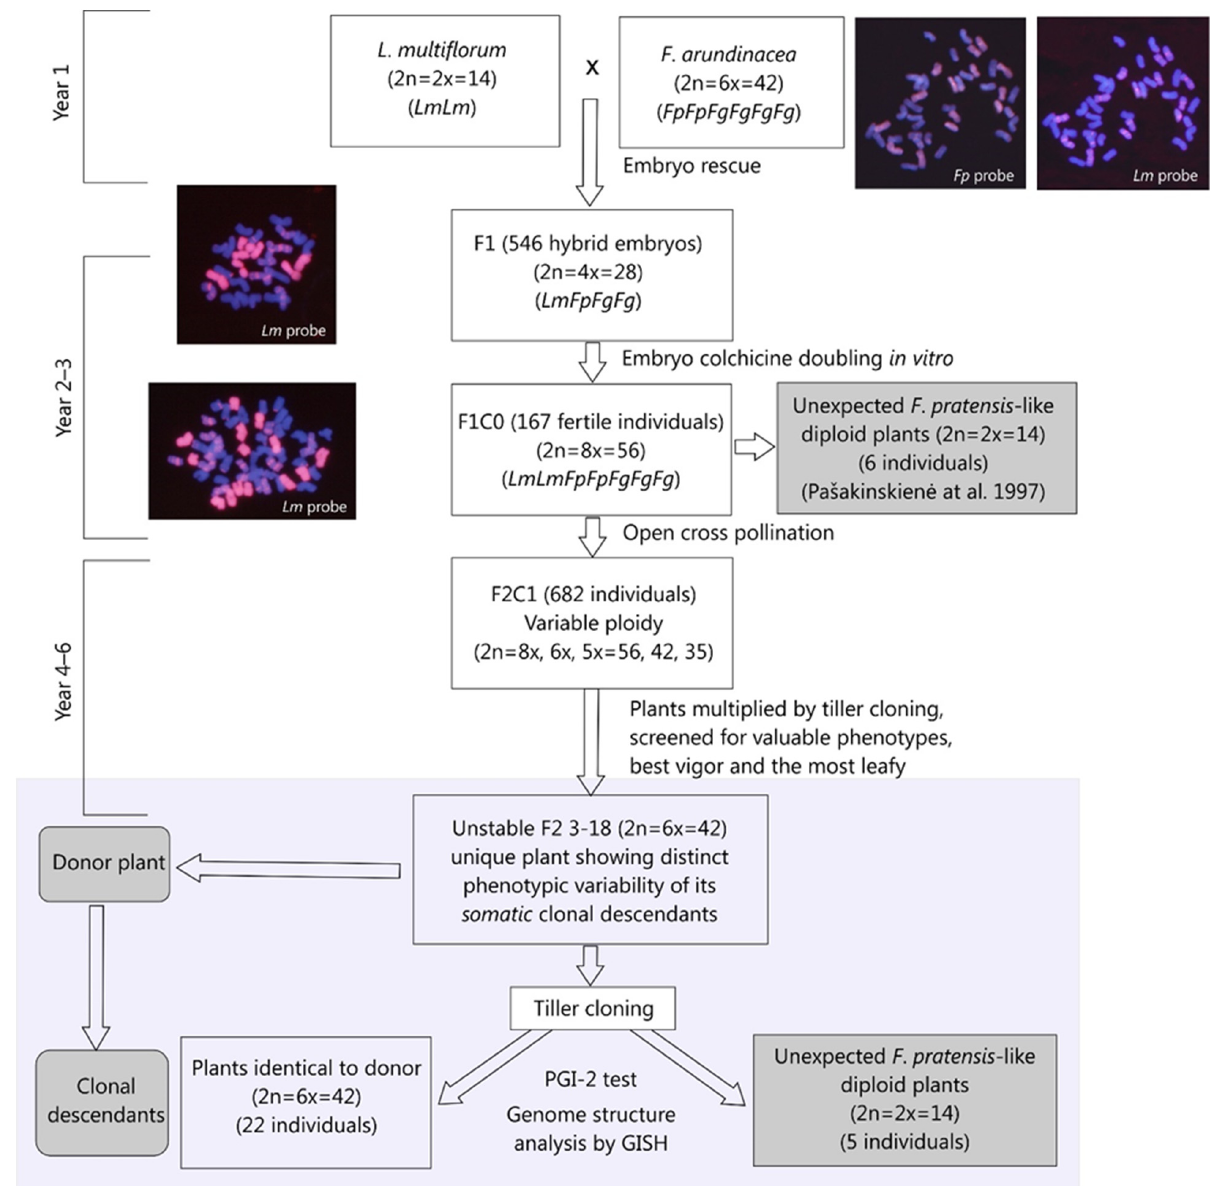
Figure 1. The scheme of the crosses and clone pedigree, together with the GISH images for the parental F. arundinacea and F1C0 and F2C1 hybrids, demonstrate the specificity of the L. multiflorum rhodamine labelled probe for highlighting simultaneously L. multiflorum (red) and F. pratensis (mauve) chromosomes. Abbreviations: Lm— L. multiflorum , Fp— F. pratensis , Fg— F. glaucescens (Fp and Fg are subgenomes comprising F. arundinacea parent). The experimental plot of this study is highlighted in light gray.